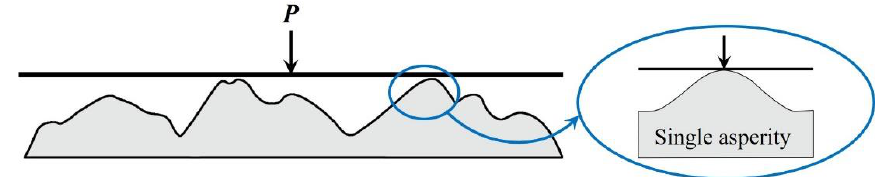
Figure 6. Schematic of GW modeling of rough surfaces and a single contact asperity.